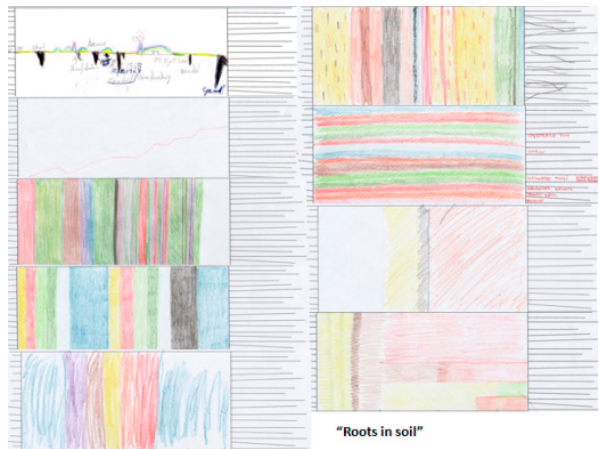
Figure 3. The nine rugs that forms the group “Roots in